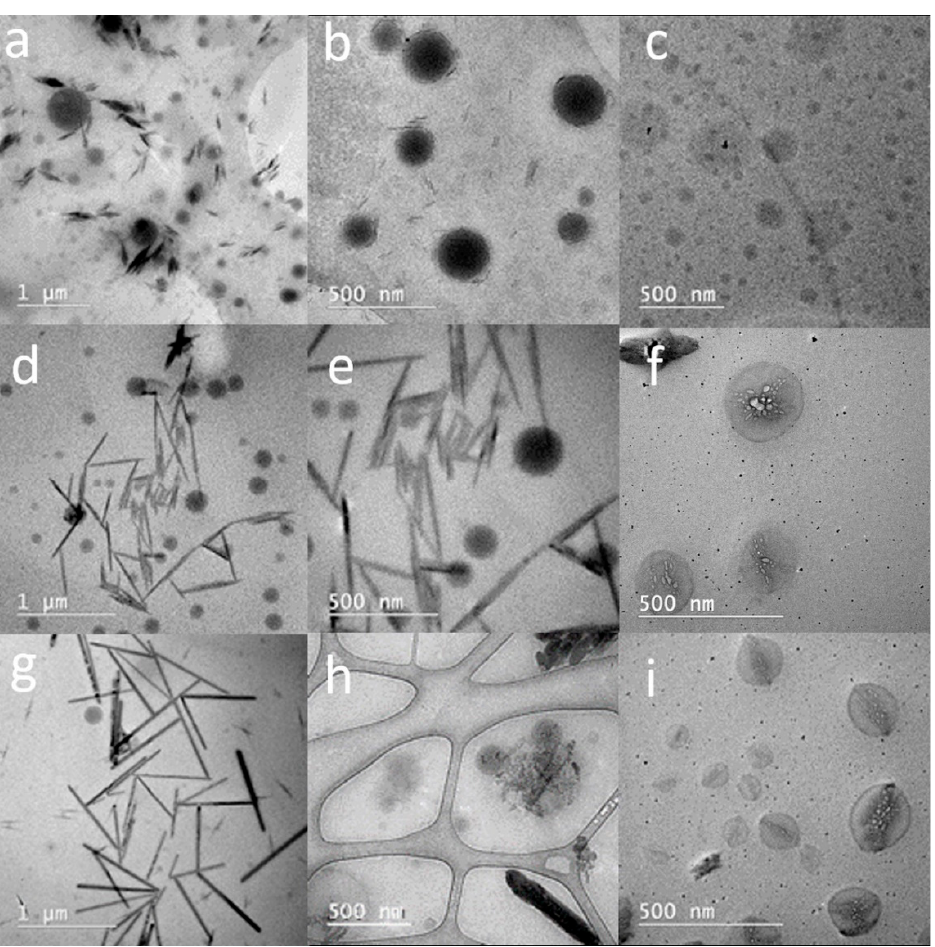
Figure 3. TEM micrograph of the NIP-LFNG (( a ) 1 μ m, ( b ) 500 nm for the final emulsion; ( c ) 500